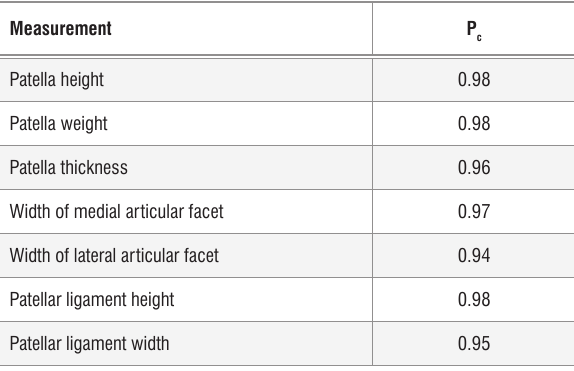
Table 2: Concordance correlation coefficient (P ducibility of measurements of the patella and patellar ligament